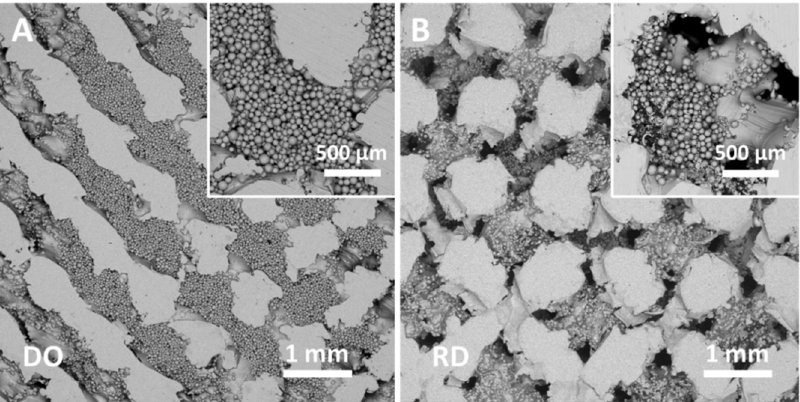
Figure 5. SEM images of the scaffold’s inner structure: ( A ) DO geometry, ( B ) RD geometry. Insets show the same area of sample at higher magnification.